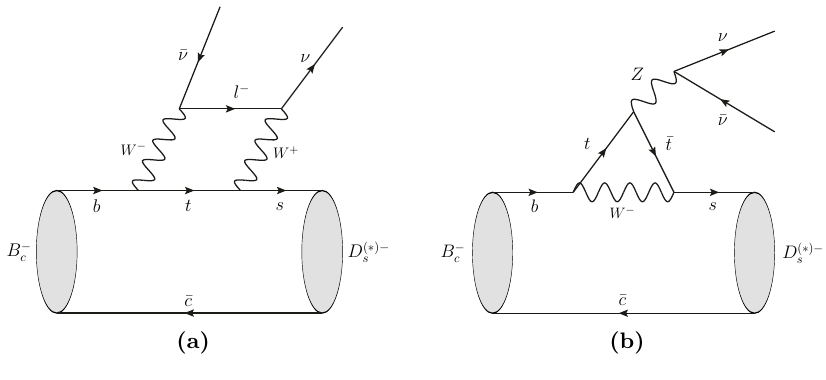
Figure 7. Feynman diagrams for the process B (cid:0)